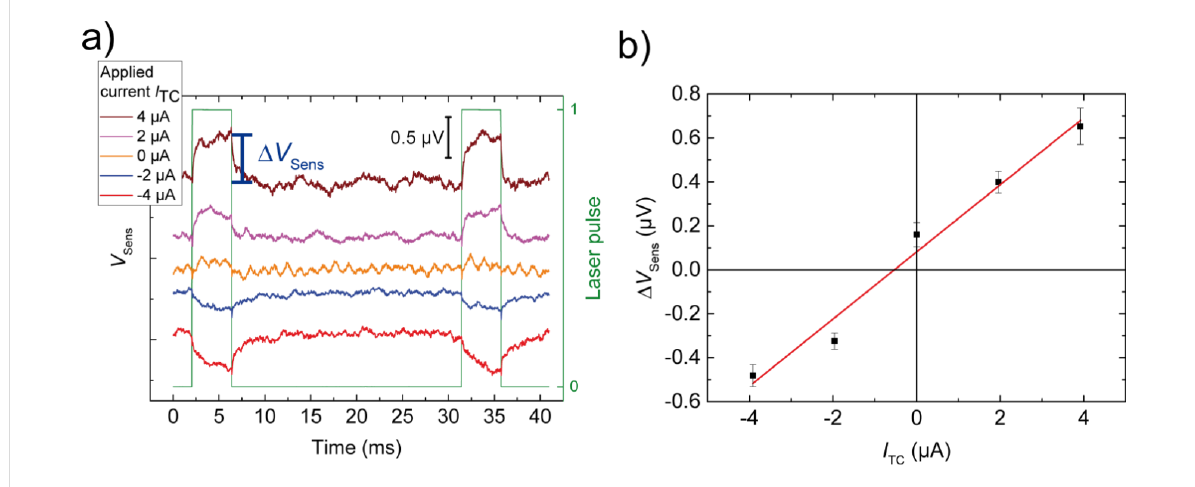
Figure 6: a) Raw data of V Sens versus time at different applied currents, while the laser is pulsing on the substrate. The pulse duration of 4 ms is indi- cated by the green line. The curves are offset vertically to avoid overlap. b) ∆ V Sens ( I ) = V Sens (on) − V Sens (off) curve, derived from the raw data in a). The error bars denote the standard deviation of the time traces while the laser was switched off, multiplied by √ 2 to account for the fact that the differ- ence between on and off time is calculated. The equation of the linear fit (red line) is ∆ V Sens = 0.15 Ω · I TC + ∆ V 0